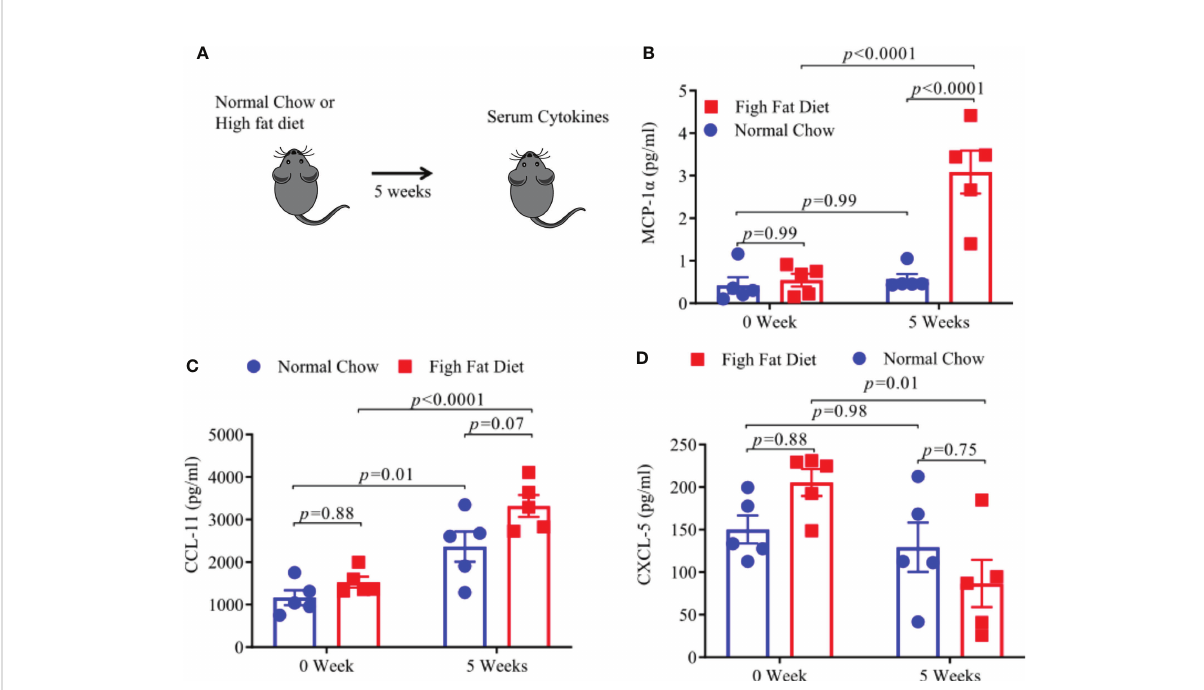
FIGURE 6 A High Fat Diet results in increase pro-in fl ammatory cytokines. (A) Schematic of experimental design. 6-8-week old HLA-DR3 transgenic male mice were placed on the indicated diet and after 5 weeks sera were collected from blood. MCP-1a concentrations post diet (B) , CCL-11 concentrations post diet (C) , CXCL-5 concentrations post diet (D) . Error bars represent the standard error of the mean for each experimental group. p -value was determined by 2way ANOVA Sidak multiple comparisons test for (B – D)